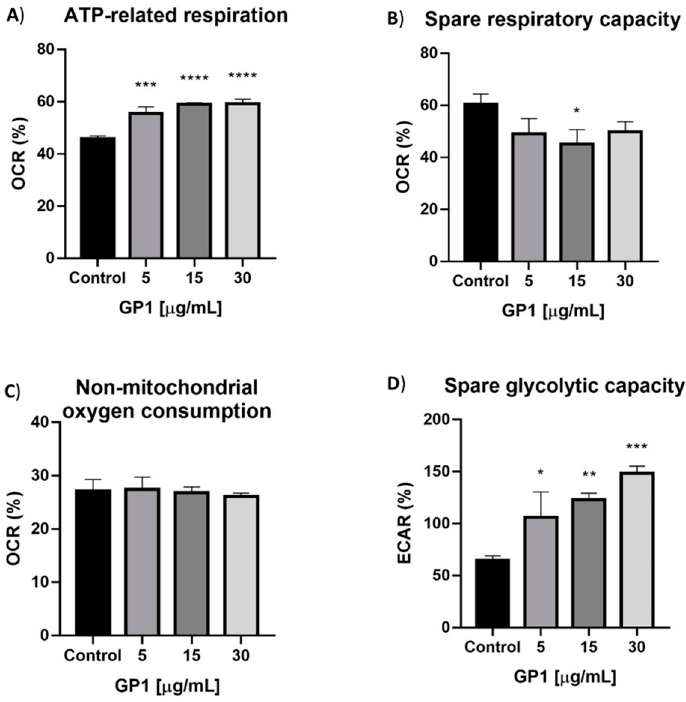
Figure 3. Analysis of metabolism after long-term treatment with GP1 in concentrations 5, 15, and 30 µg/mL using a Seahorse XFe96 analyzer (Agilent Technologies, Santa Clara, CA, USA). ( A ) ATP- related respiration, ( B ) spare respiratory capacity, ( C ) non-mitochondrial oxygen consumption, and ( D ) spare glycolytic capacity. Data represent the mean expressed as percentage of basal state ± SD of the three different experiments. Statistical significance was evaluated with One-way ANOVA Dunnett’s multiple comparisons test. Significant differences from control * p < 0.0332 ** p < 0.0021 *** p < 0.0002 **** p < 0.0001.